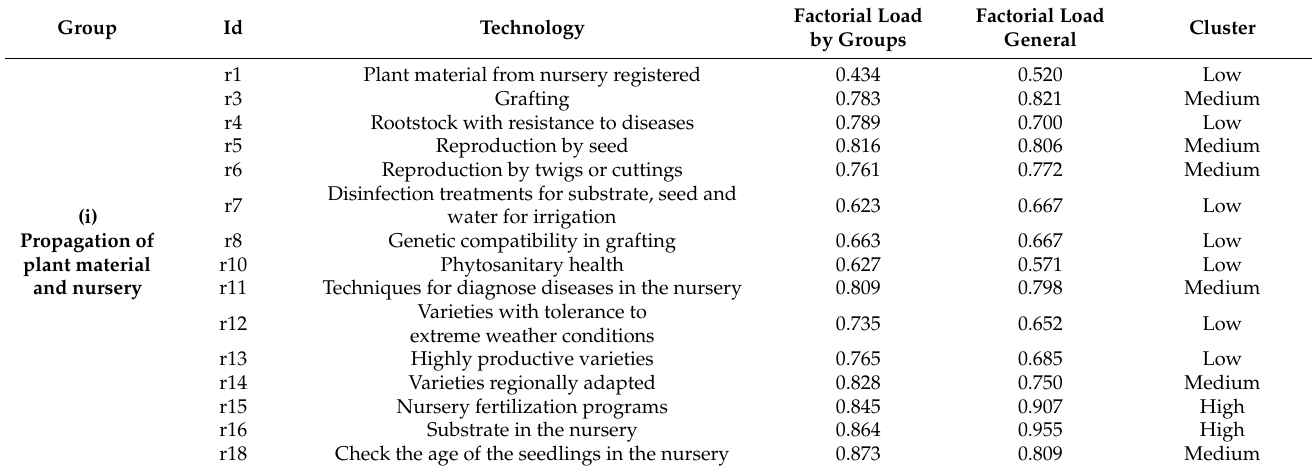
Table A2. Factor Loads and Cluster by Importance of Technology. Analysis by Technology Group and by Technology in General. Three Clusters Were Used for the